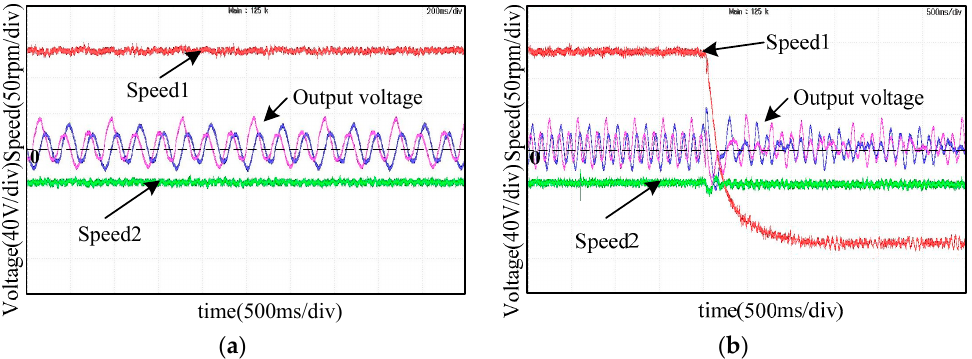
Figure 18. The voltage a speed waveform of voltage open − loop control based on DFV − SVPWM: ( a ) steady state; ( b ) dynamic state.